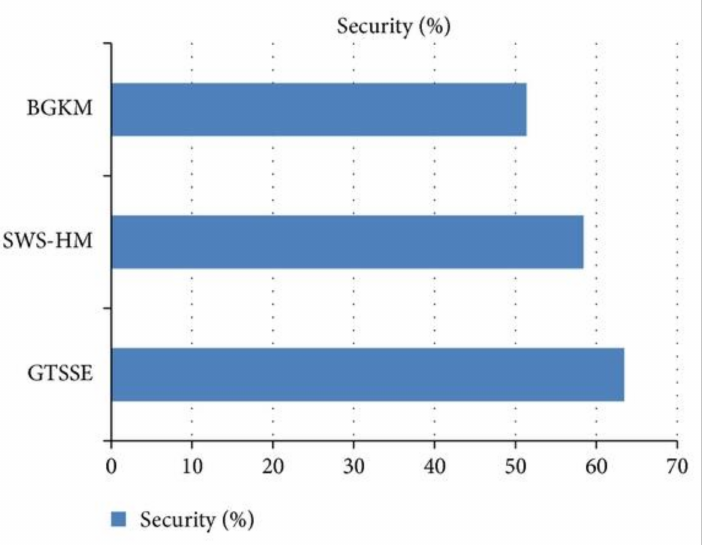
Figure 10. Result of security ratio for GTSSE model compared to other existing